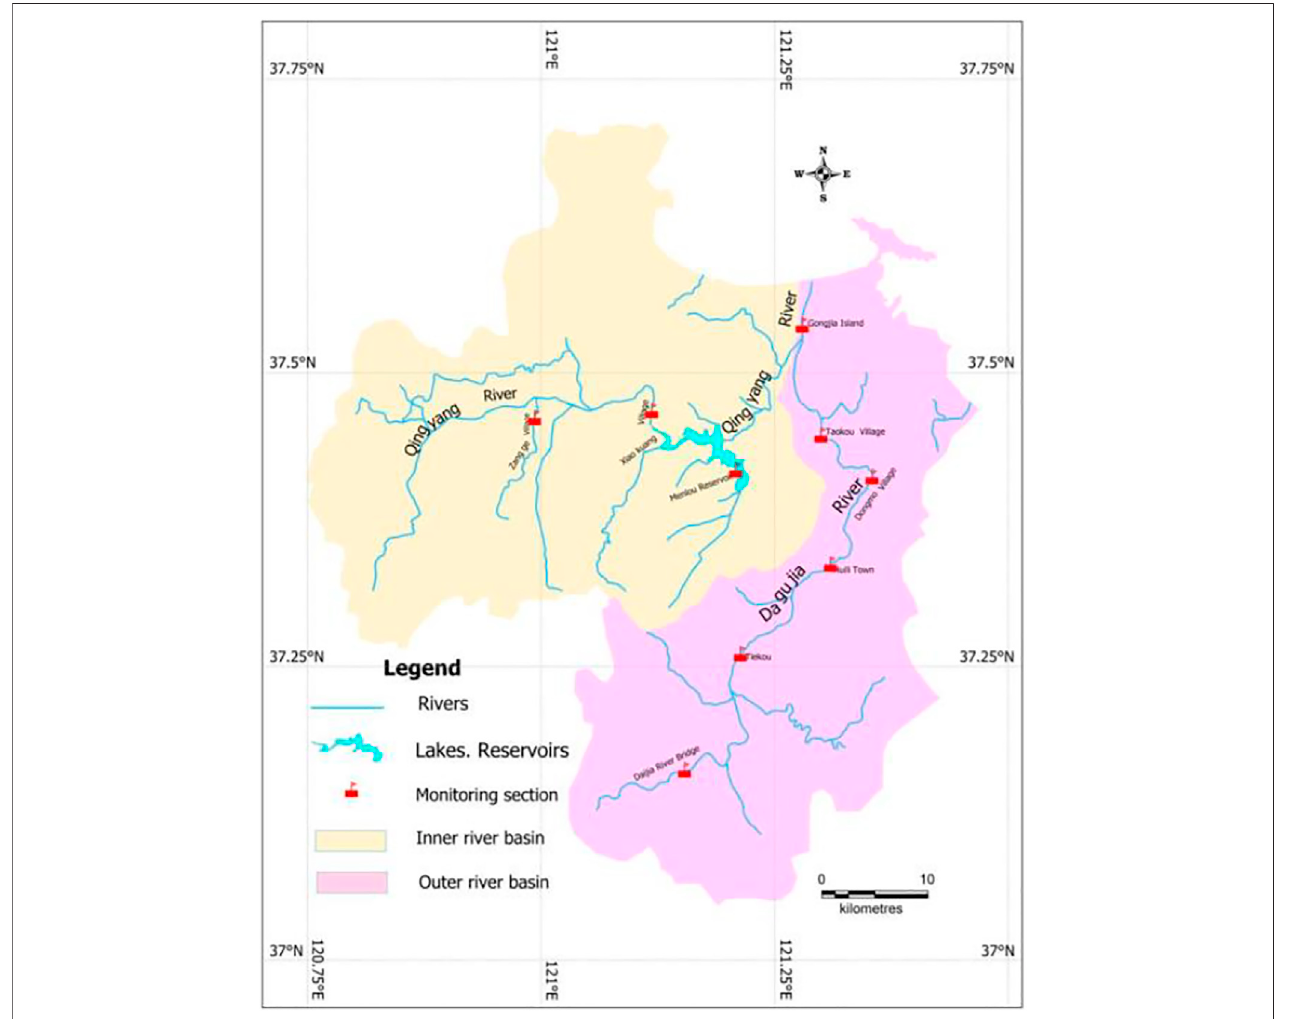
FIGURE 2 | River system of the Dagujia river watershed.